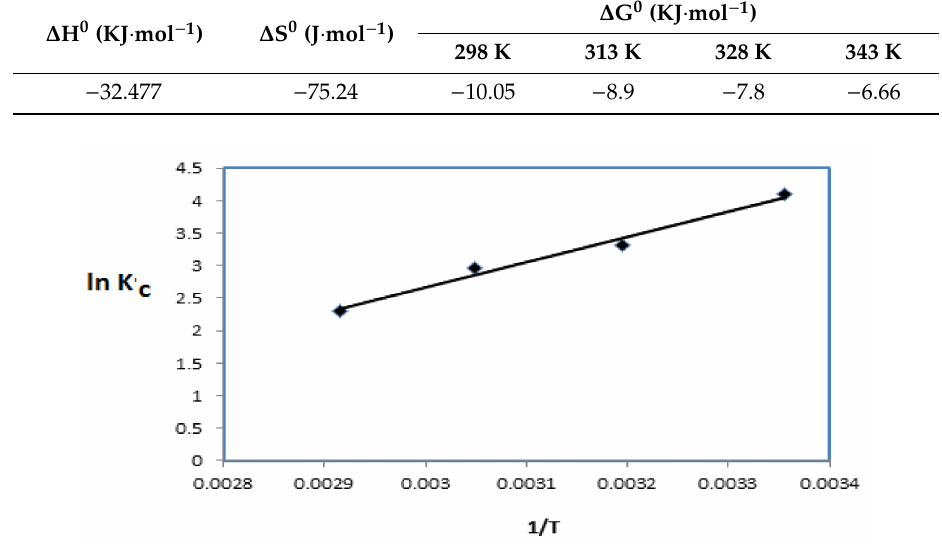
Figure 15. Van’t Ho ff plot for the adsorption of CR by QVP / AAm-Fe 3 O 4 .